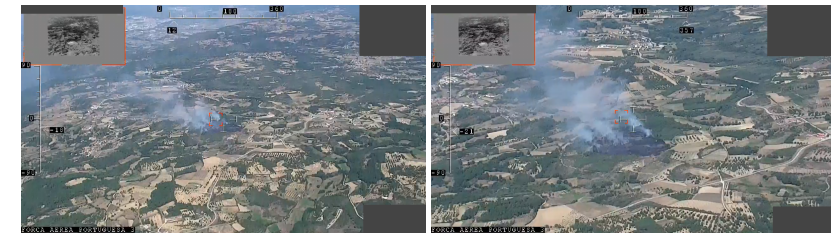
Figure 17. Sample frames of the Chaves video.